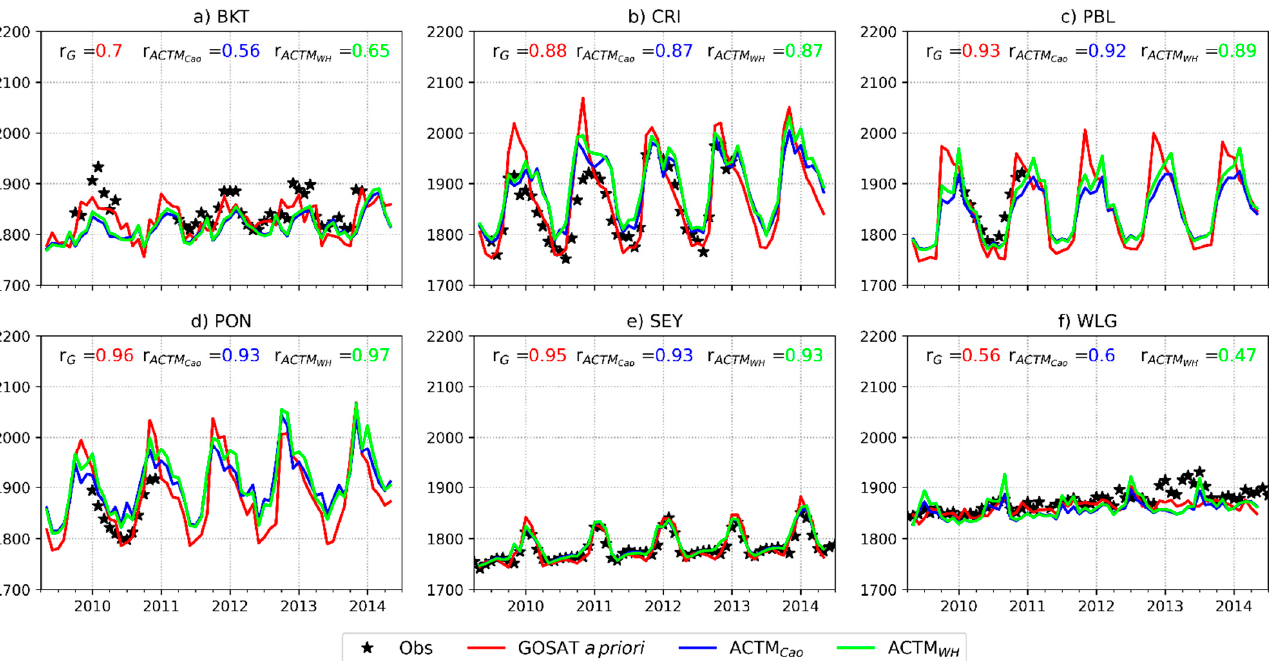
Figure 13. Seasonal variation of monthly mean CH 4 derived from ground observations, GOSAT a priori, ACTM Cao and ACTM WH over observational sites: ( a ) BKT, ( b ) CRI, ( c ) PBL, ( d ) PON, ( e ) SEY, and ( f ) WLG. Correlation coefficient ( r ) was calculated for observations vs. GOSAT a priori (r G ), and observations vs. model simulations (r ACTM site are shown in the upper part of the panels.